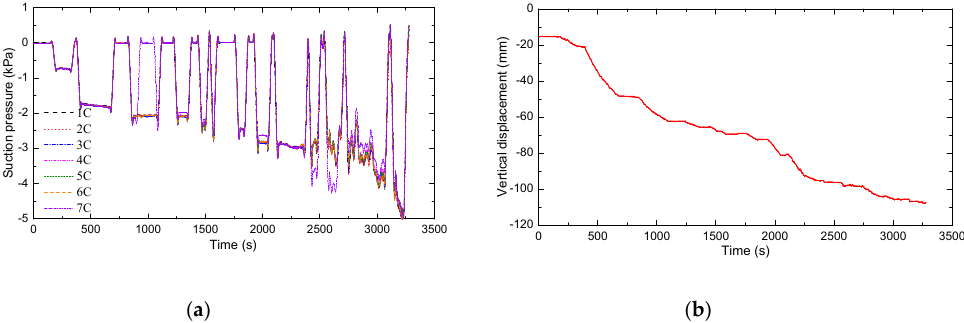
Figure 9. Variations in suction and displacement with time in PS2-2. ( a ) Relationship between suction and time; ( b ) Relationship between displacement and time.